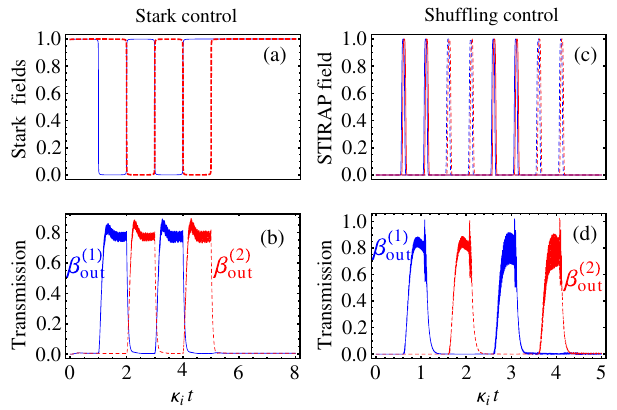
FIG. 5. All-optical routing in output channels (a),(b) Stark control and (c),(d) shuffling control. Parts (b) and (d) show the light in the output channels and prove that one can reroute the light into the two separate output channels with a near-perfect contrast (bright and dark). Parts (a) and (c) depict the Stark and STIRAP classical control pulses used. Initially, h ^ (cid:1) 11 ð 0 Þi ¼ 1 in Stark control protocol but h (cid:1) 22 ð 0 Þi ¼ 1 in shuffling control. The ~(cid:3) ð l Þ ~(cid:3) ð l Þ and are parameters and the profiles for the control fields p s the same as in Fig. 3. The solid and dashed lines in (a) and (c) indicate the field applied to control scatterers 1 and 2, respec- tively. The solid blue lines in (b) and (d) are for the output (cid:2) ð 1 Þ out , but the dashed red lines are for (cid:2) ð 2 Þ out . The blue lines in (c) ~(cid:3) ð l Þ ~(cid:3) ð l Þ ; the red lines are . represent the field p s